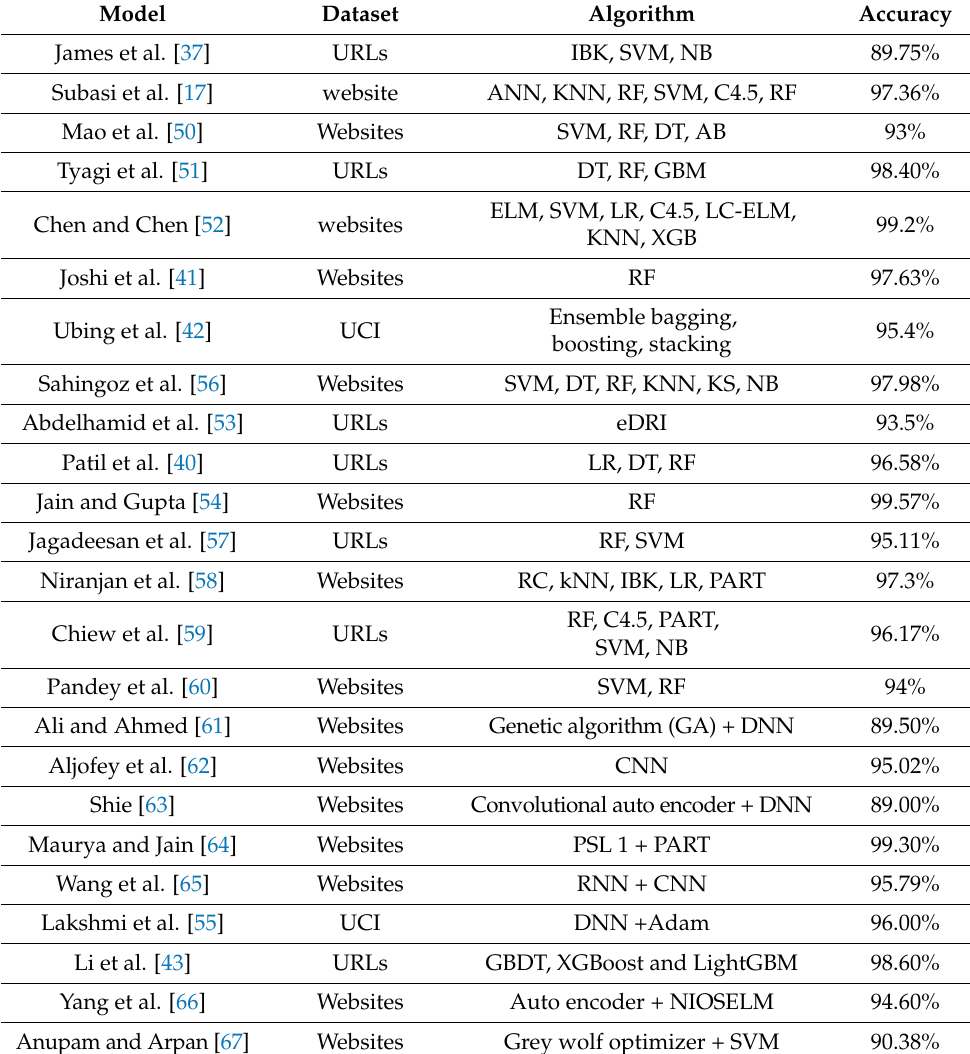
Table 1. Comparison table of the latest research focusing on machine learning phishing detection